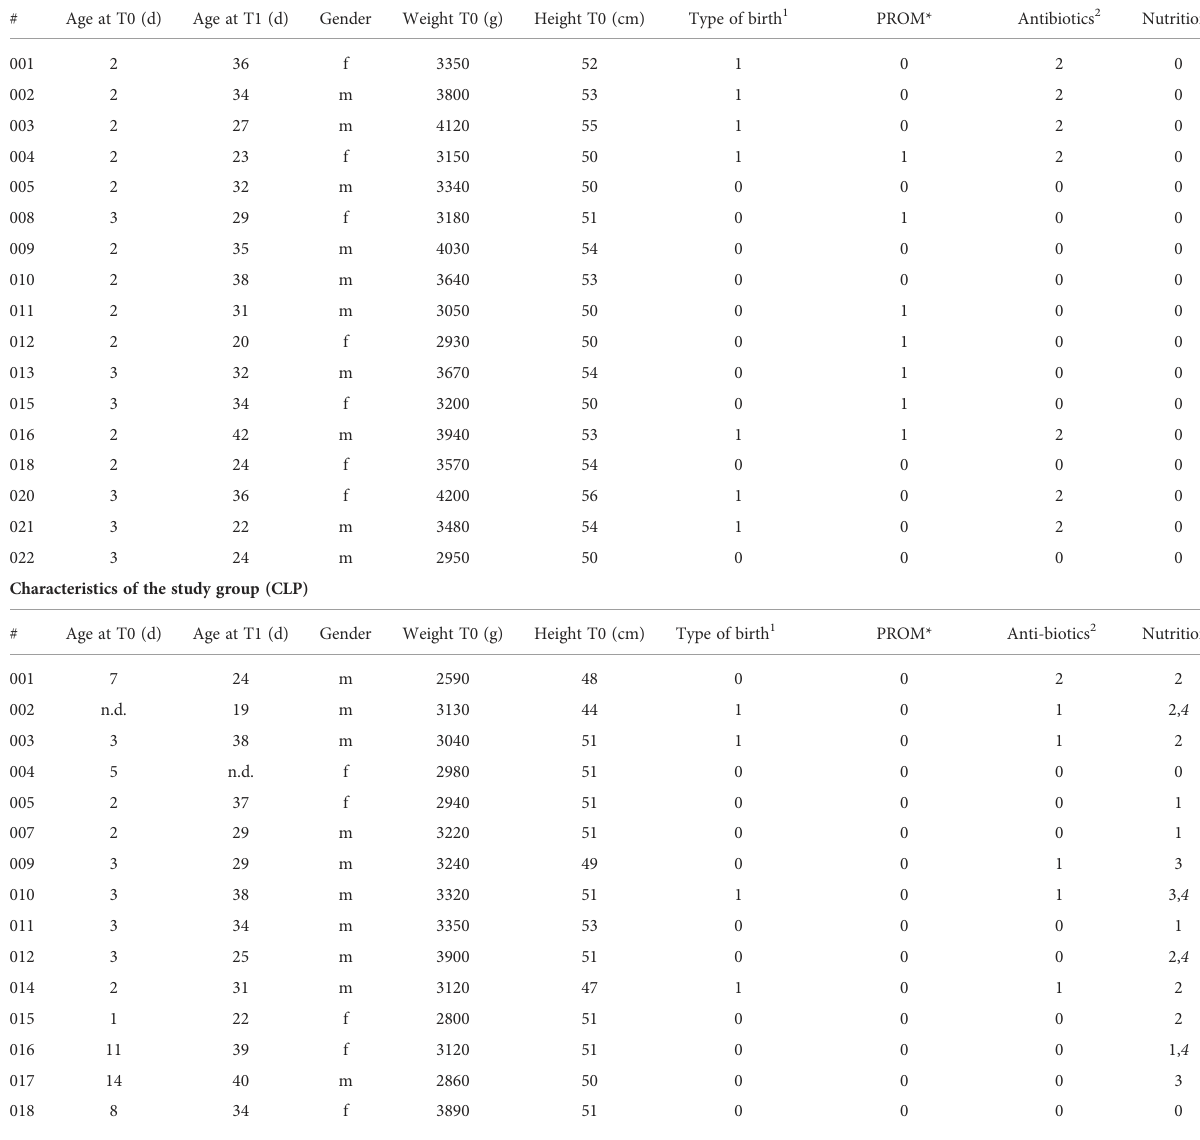
TABLE 2 Characteristics of Study